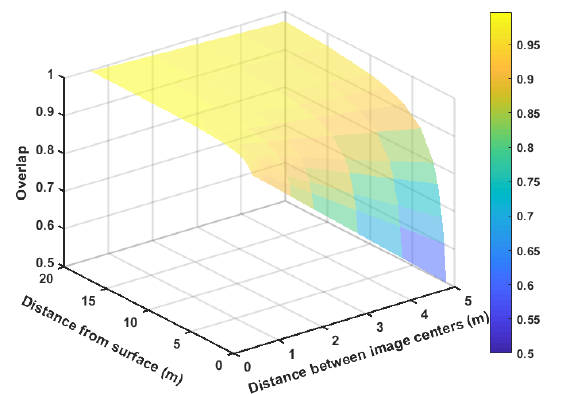
Figure 4. Simulated overlap